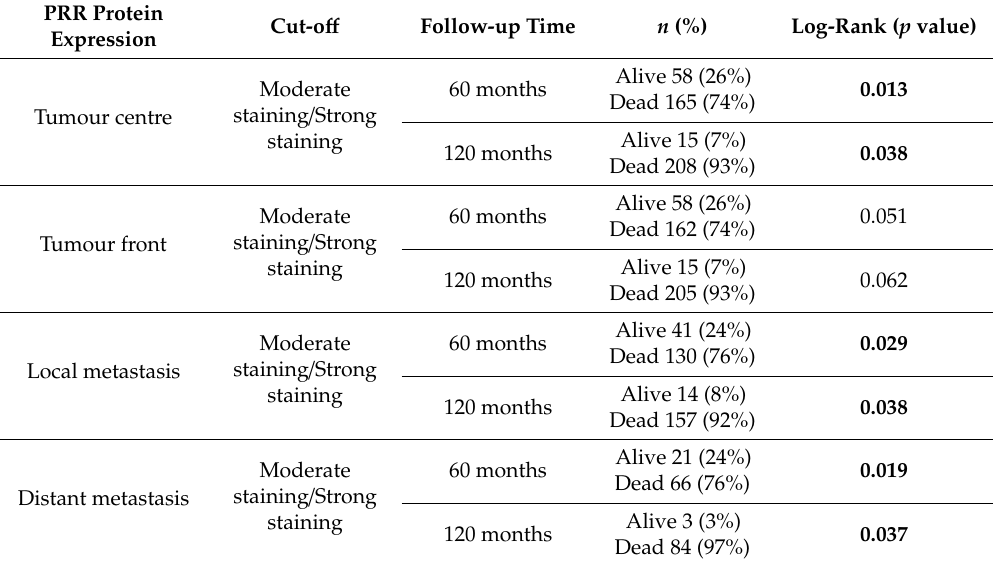
Table 4. Log-rank test results of the association between PRR expression in primary tumours and metastases and 5- and 10-year overall survival of CRC patients.